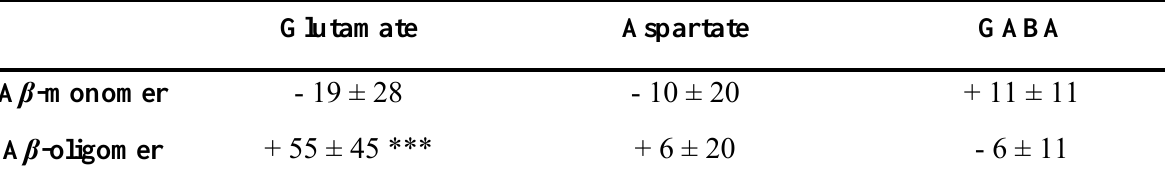
Table 2. Dorsal hippocampal dialysate glutamate, aspartate and GABA levels following ipsilateral icv injection of either the A β monomer or oligomer expressed as percent change from basal (calculated as the mean of the two 20 min dialysate samples prior to icv A β injection). Each value represents the mean ± standard error of the mean ( SEM) of thirteen 20 min dialysate fractions (260 min) collected following A β injection. See Table 1 for absolute basal levels. (n= 5-7 animals per group). ***=P<0.0001 vs. monomer-injected control